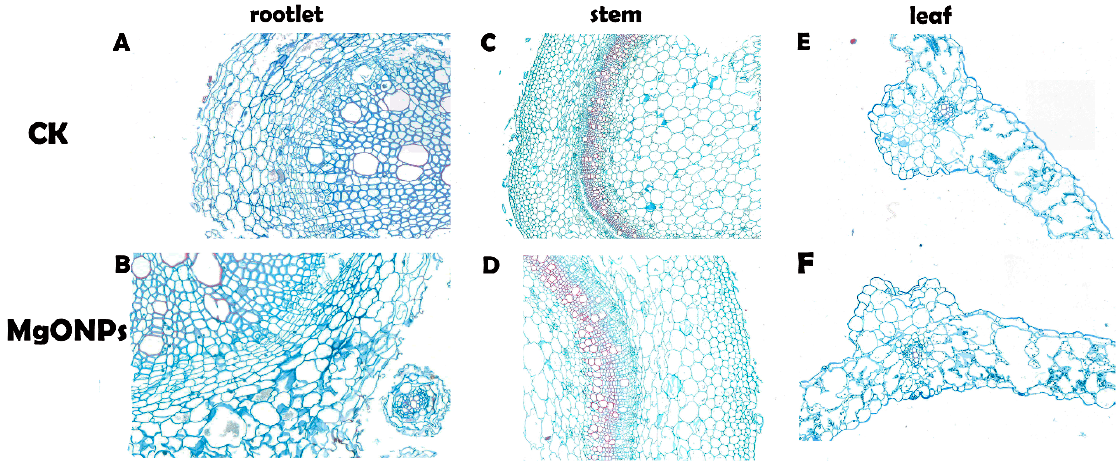
Figure 4. Paraffin section images (cross-sections) of the tobacco roots ( A , B ), stems ( C , D ) and leaves ( E , F ) exposed to 250 µ g/mL of MgONPs and distilled water.